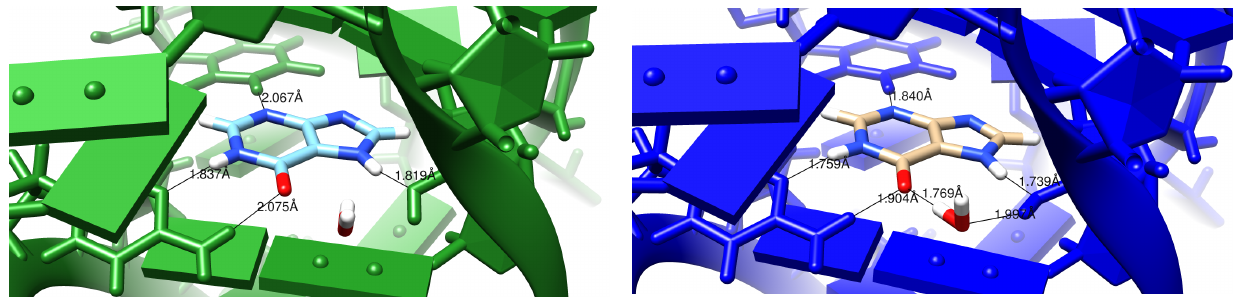
Figure 3. Images comparing conventionally and AMBER-restrained (green and blue, respectively) refinement outputs for 4fe5 [28]. The difference here is in distances and also the additional hydrogen bonds involving a nearby solvent molecule in the AMBER image. The ligand being examined is hypoxanthine (HPA).